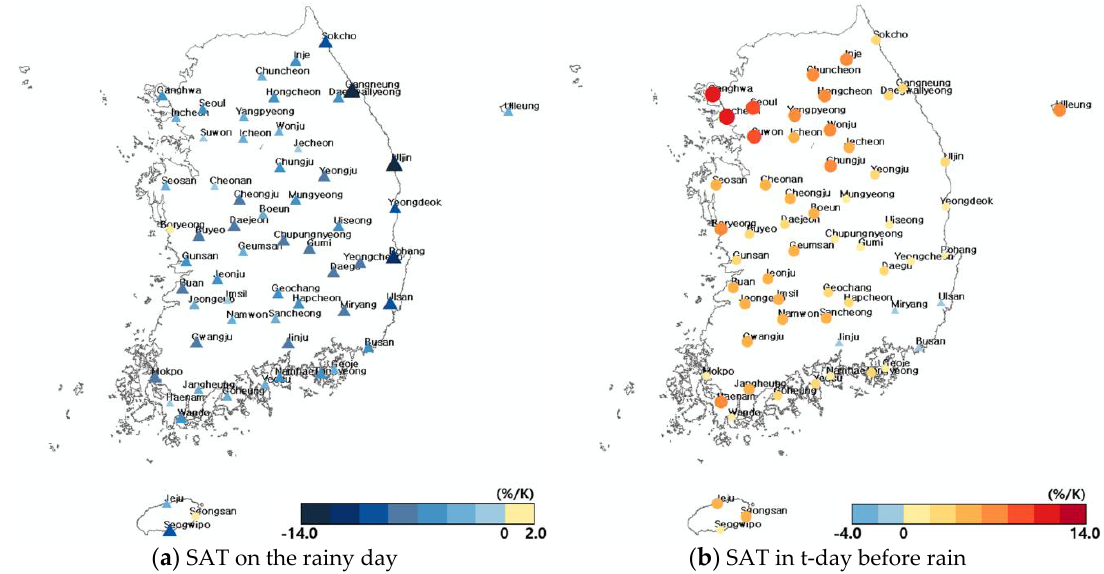
Figure 2. Sensitivity of 95% daily rainfall depth to SAT in all sites.